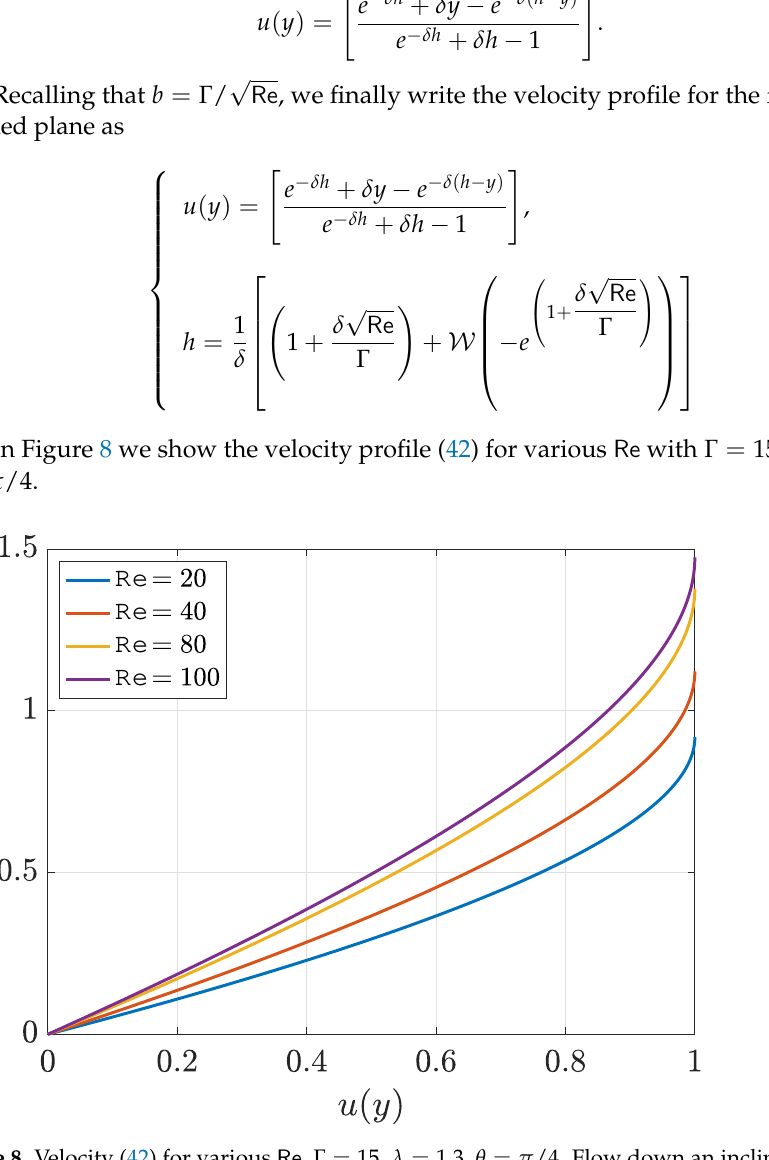
Figure 8. Velocity (42) for various Re , Γ = 15, λ = 1.3, θ = π /4. Flow down an